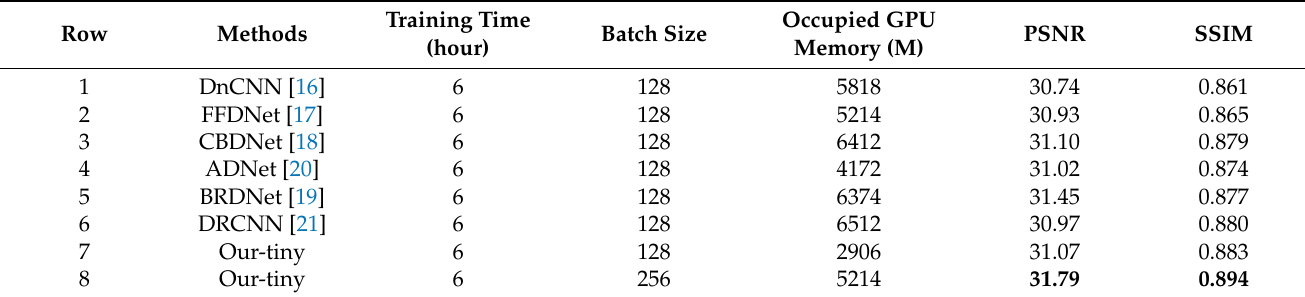
Table 4. Training and testing details of different denoising methods on the nuclear radiation dataset. The best quantitative results are marked in